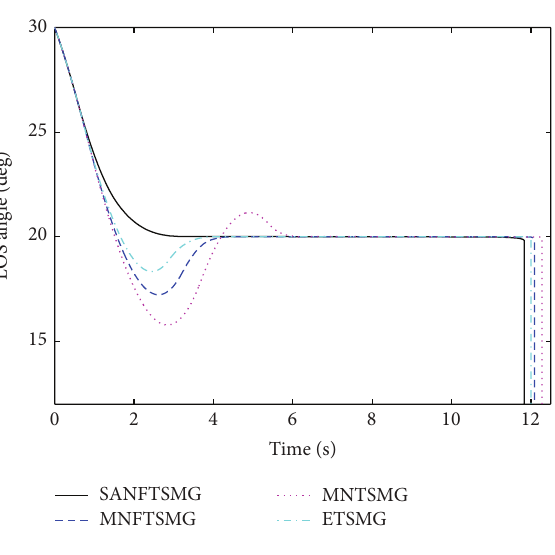
Figure 29: LOS angle (Case 3).